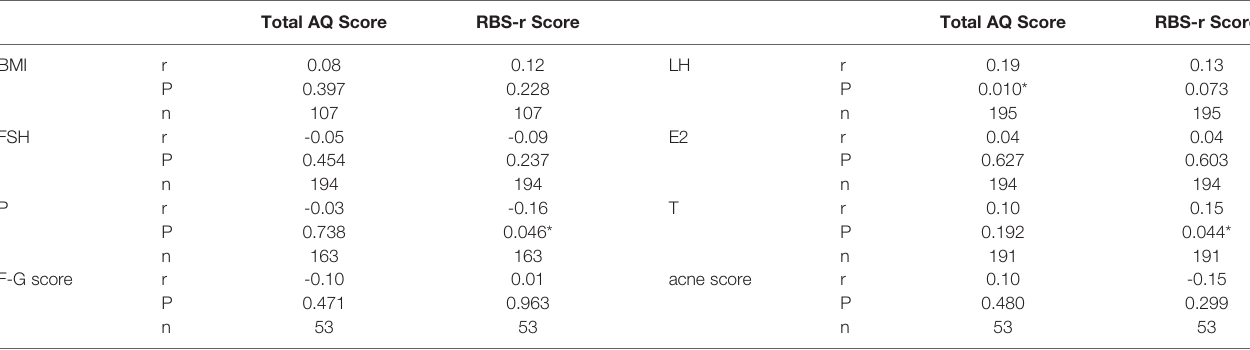
TABLE 2 | Correlation between total AQ score, RBS-r score and sex hormone levels, F-G score, acne score, and BMI.